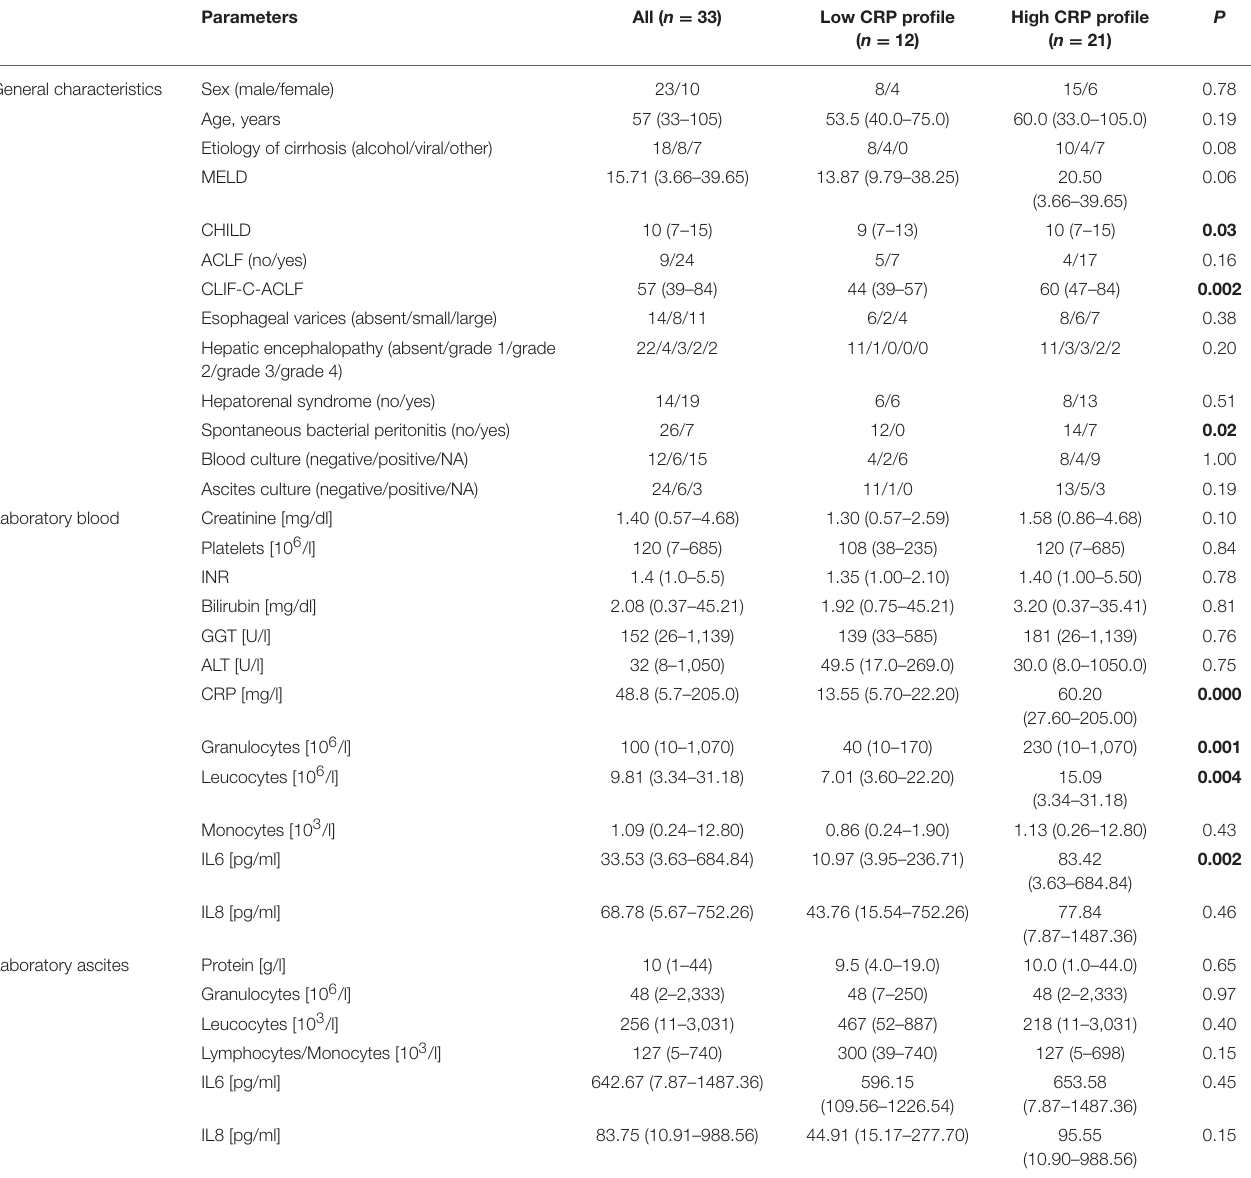
TABLE 1 | Patient